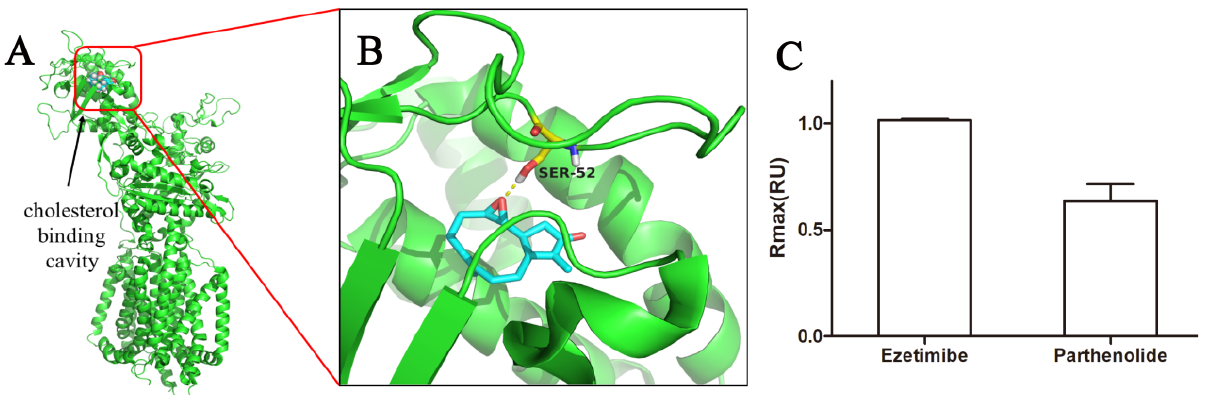
Figure 1. ( A ) Inhibitory effect of PTL on cholesterol absorption in Caco ‐ 2 cells. Caco ‐ 2 cells were pretreated with PTL at different concentrations for 4 h and then incubated with NBD ‐ cholesterol for 1 h. ( B ) Inhibitory effect of ezetimibe on cholesterol absorption in HepG2 cells. HepG2 cells were pretreated with ezetimibe at different concentrations for 4 h and then incubated with NBD ‐ cholesterol for 1 h. ( C ) Inhibitory effect of PTL on cholesterol absorption in HepG2 cells. HepG2 cells were pretreated with PTL at different concentrations for 4 h and then incubated with NBD ‐ cholesterol for 1 h. Values are expressed as mean ± SD of three to five experiments. ( # : control, * p < 0.05, ** p < 0.01, *** p < 0.001, compared to control).